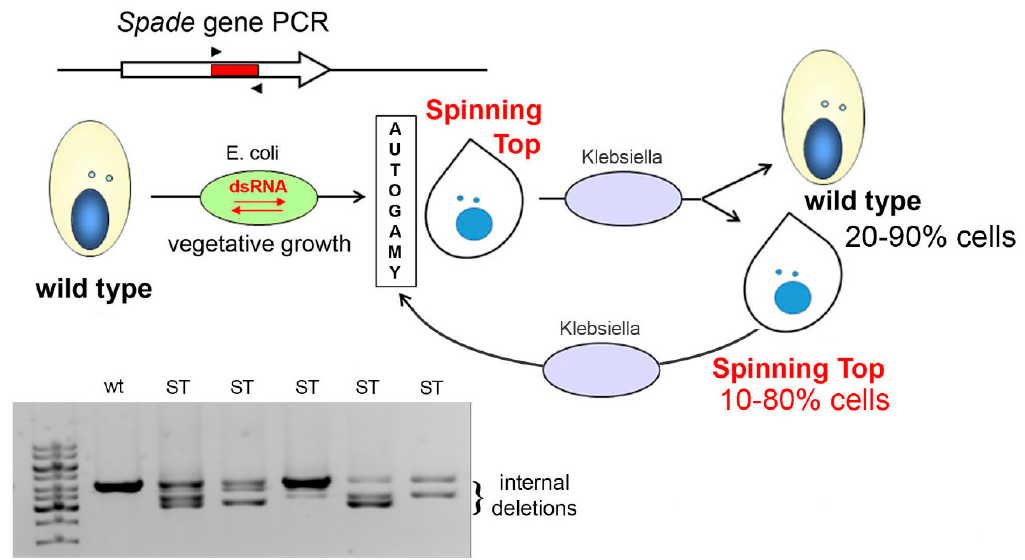
Figure 7. dsRNA feeding during autogamy results in imprecise deletions in the target locus. A segment from the Spade gene was inserted into the vector used for dsRNA production in E. coli . Cells underwent autogamy in the feeding medium, which resulted in variable ratios of wild-type (wt) and Spinning Top (ST) phenotypes among postautogamous progeny. All postautogamous clones showed internal deletions in at least a fraction of copies of the target locus, as detected by PCR using primers SPaD1 and SPaD2 (Table S2). In each life cycle, after the cells with induced MAC deletions undergo autogamy, they continue to produce wild-type and mutant cells in different ratios in vegetative progeny.